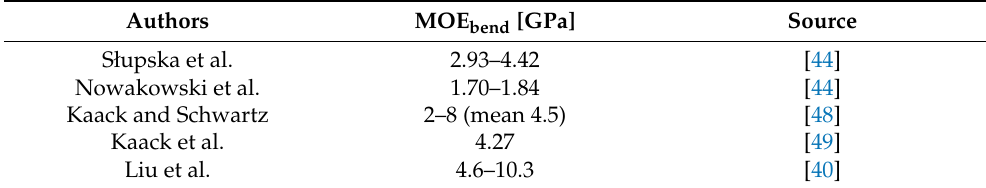
Table 1. Summary of test results on miscanthus bending (Dry